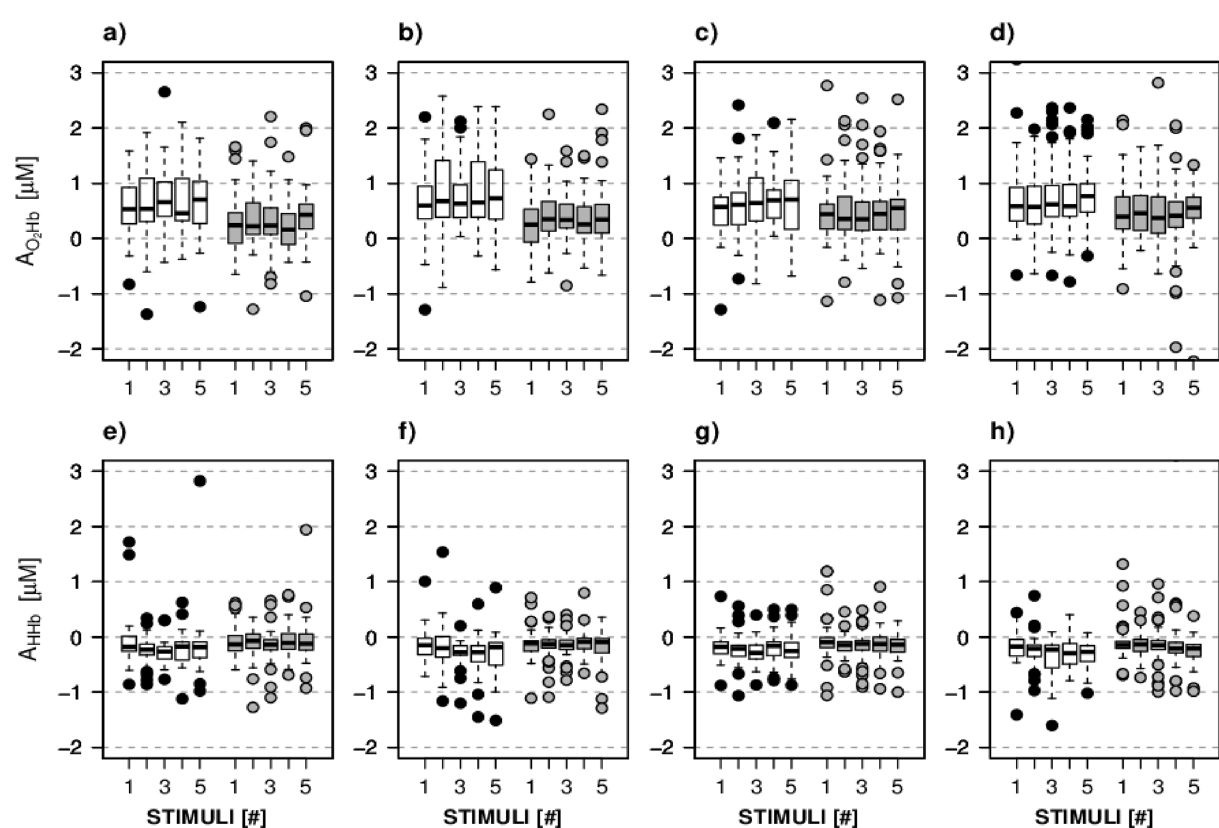
Figure 2. Distribution of A O2Hb ( a–d ) and A HHb ( e–h ) over the 5 stimuli for healthy eyes (NORM, white) and glaucomatous eyes (GLAUCOMA, grey). ( a,e ) Left eye, left hemisphere; ( b,f ) left eye, right hemisphere; ( c,g ) right eye, left hemisphere; ( d,h ) right eye, right